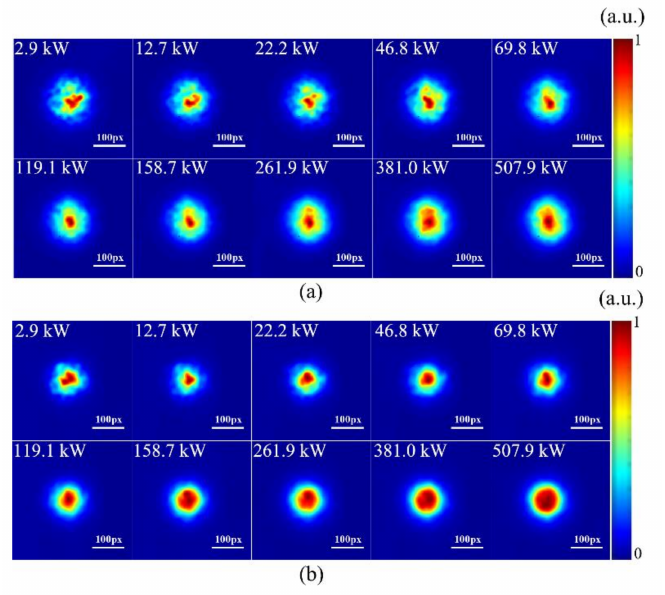
Figure 6. Output beam profiles from the MMFs with tapered length of ( a ) 1.7 cm and ( b ) 5.0 cm under different input peak powers (scalebar: 100 pixels).